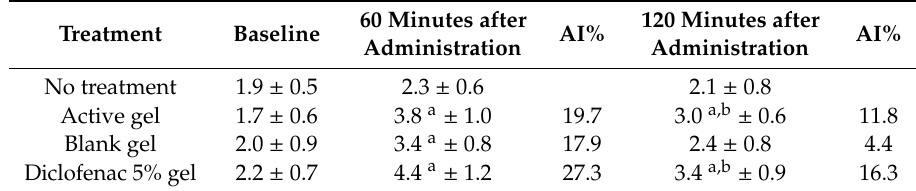
Table 4. Tail-flick latency